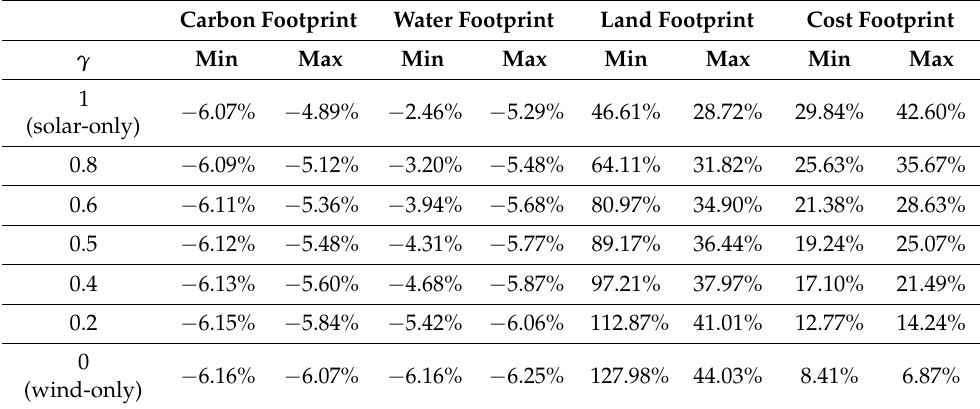
Table 6. Sustainability Evaluation for Different Fulfillment Strategies. Carbon Footprint Water